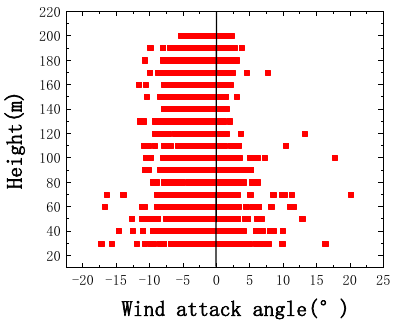
Figure 12. Height relationship diagram of wind attack angle.